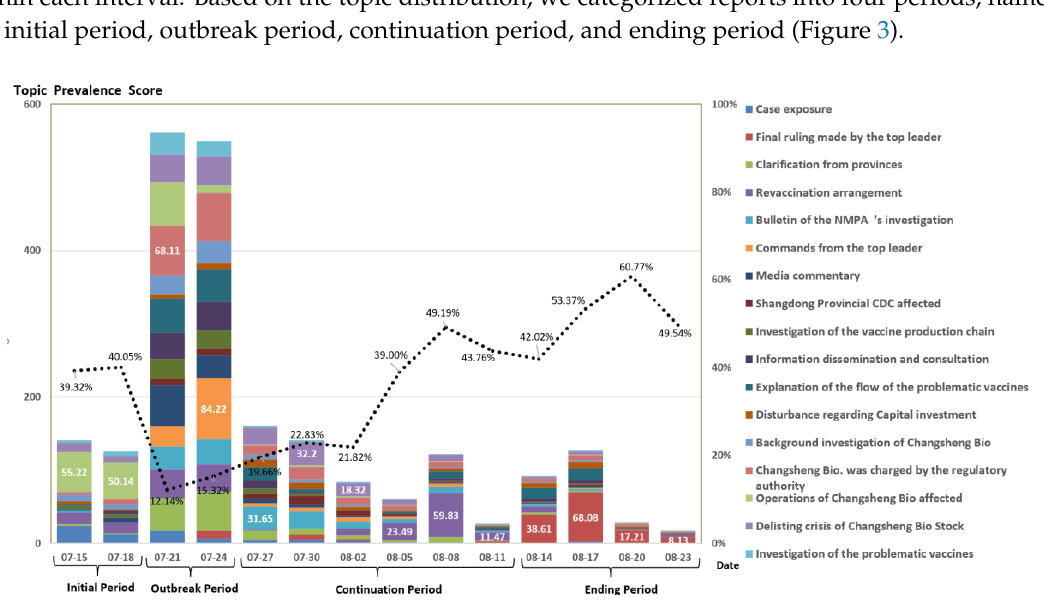
Figure 3. Prevalence and temporal variation of the topics. Note: The dotted line is the proportion of the highest prevalence topics at a certain time point.